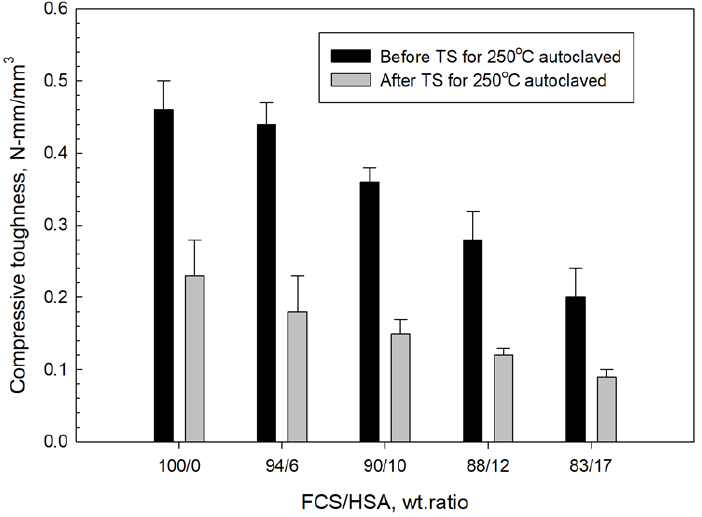
Figure 31. Compressive toughness of 250 °C-autoclaved CaP cements made with different FCS/HSA ratios before and after thermal shock (TS) tests.